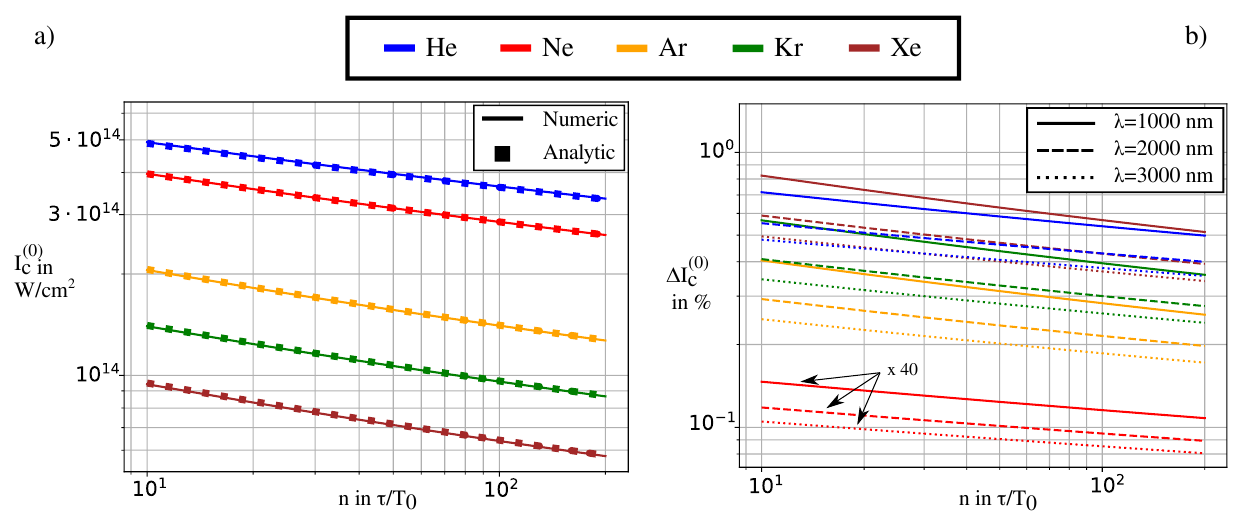
Figure 2. ( a ) The critical intensity (log scale) is calculated as a function of the pulse duration measured in multiples of the optical period (log scale). The ionization rates are calculated within the ADK model for a wavelength of λ = 1000nm in neutrally charged noble gases (color). ( b ) Error of the analytic solution compared to the numerical integration (log scale) depending on the pulse duration (log scale) for wavelengths of λ = 1000,2000,3000nm (line type) in neutrally charged noble gases (line